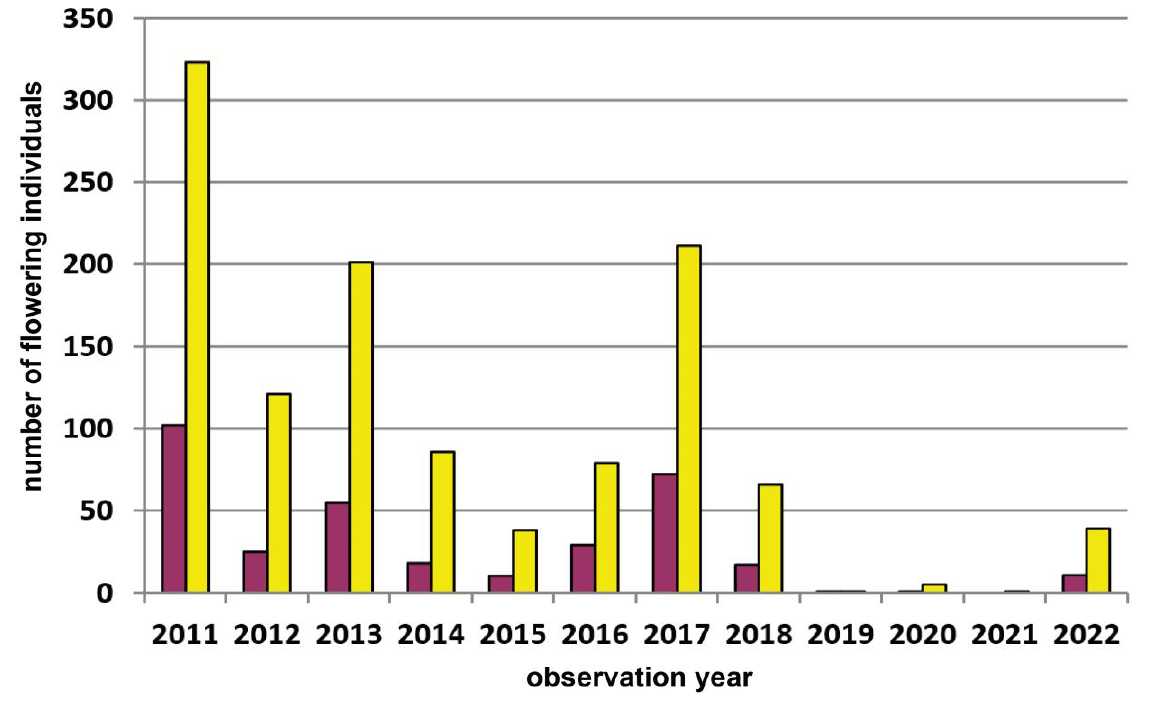
Figure A3. Population census (2011 – 2022) of the Dactylorhiza sambucina -population Voitsau II in the Waldviertel region. Red columns = red-flowering plants and yellow columns = yellow-flowering plants.